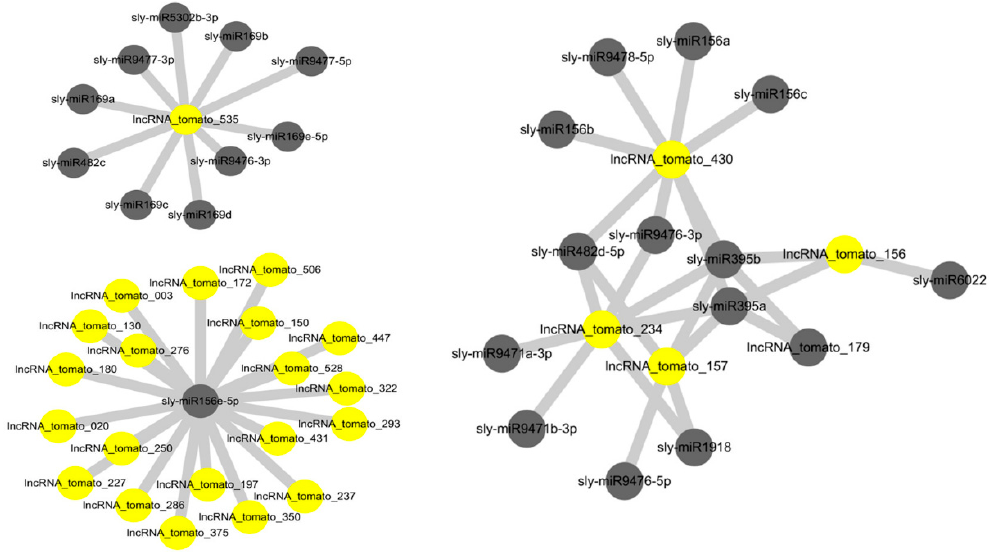
Figure 2. LncRNA–miRNA interaction network. Yellow circle nodes represent lncRNAs, and gray circle nodes represent miRNAs. Examples of interactions are shown: one lncRNA with many miRNAs, one miRNA with many lncRNAs, and many lncRNAs with many miRNAs.